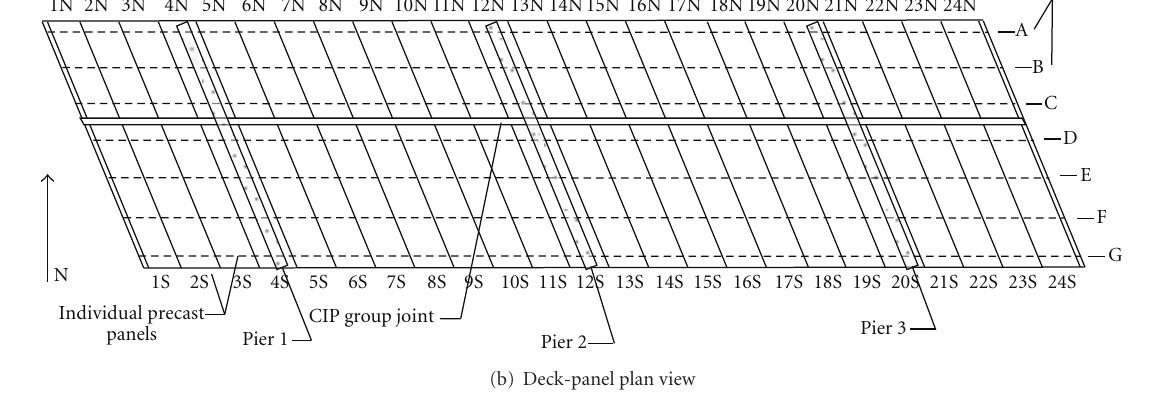
Figure 1: Parkview bridge schematic.